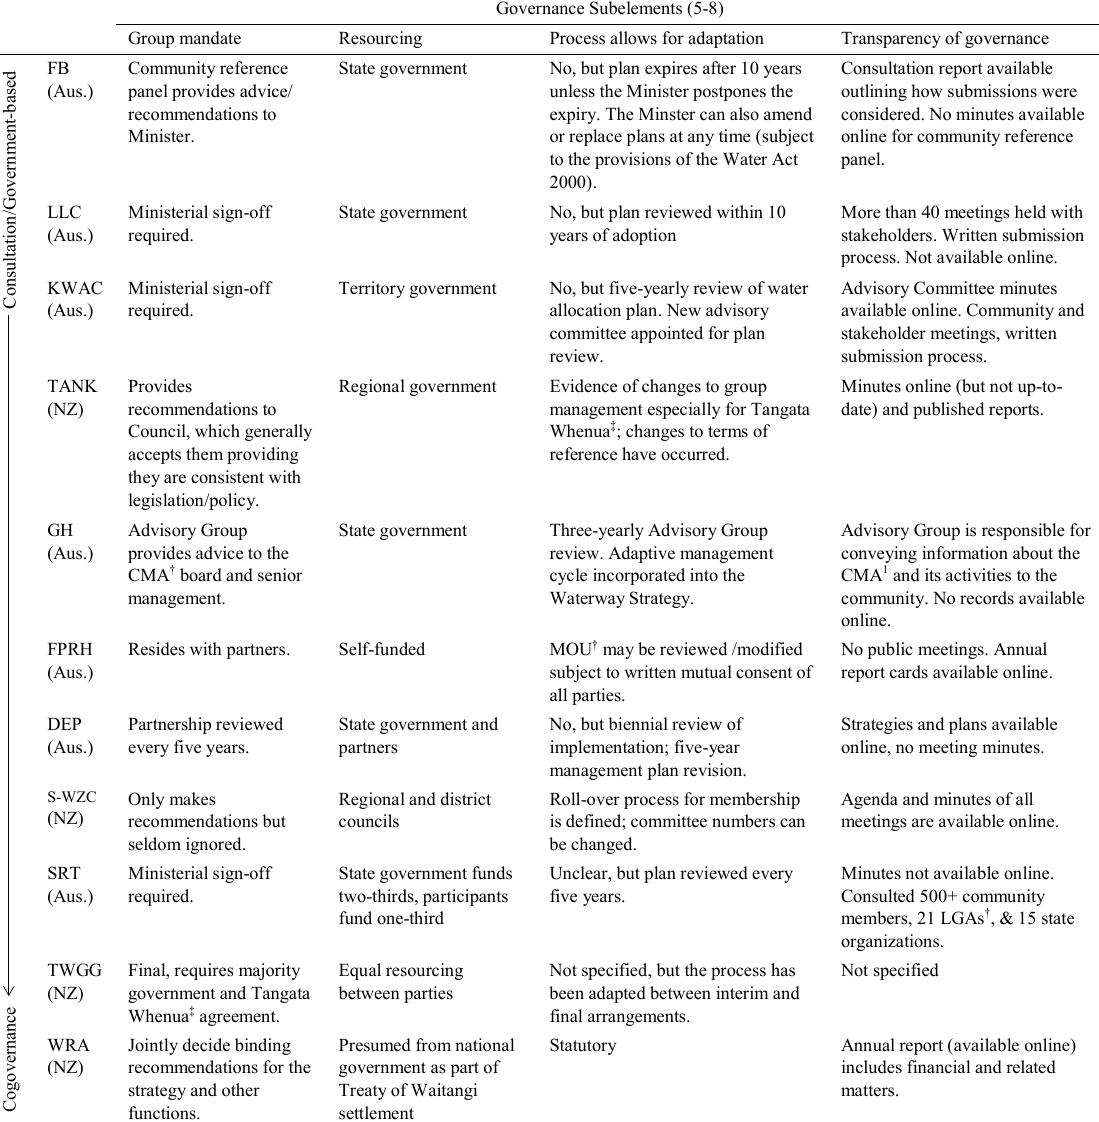
Table 5 . Categorization of collaborative groups along the consultation/government-based to cogovernance continuum: Governance subelements